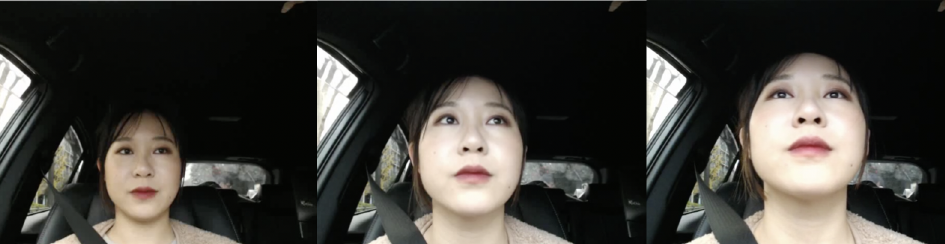
Figure 1. Left: Driver’s face facing front with a large distance to the camera. Middle: Driver’s face facing front with a middle distance to the camera. Right: Driver’s face facing front with a small distance to the